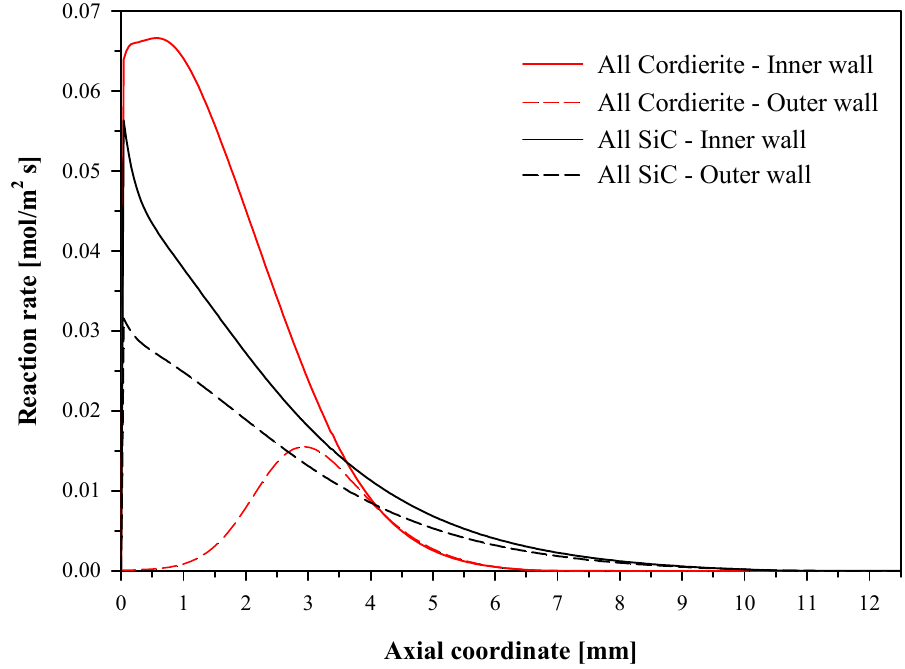
Figure 4. Axial profiles of (catalytic) reaction rate along the inner and outer walls of the inlet channel at V in = 0.5 m/s: All Cordierite and All SiC.